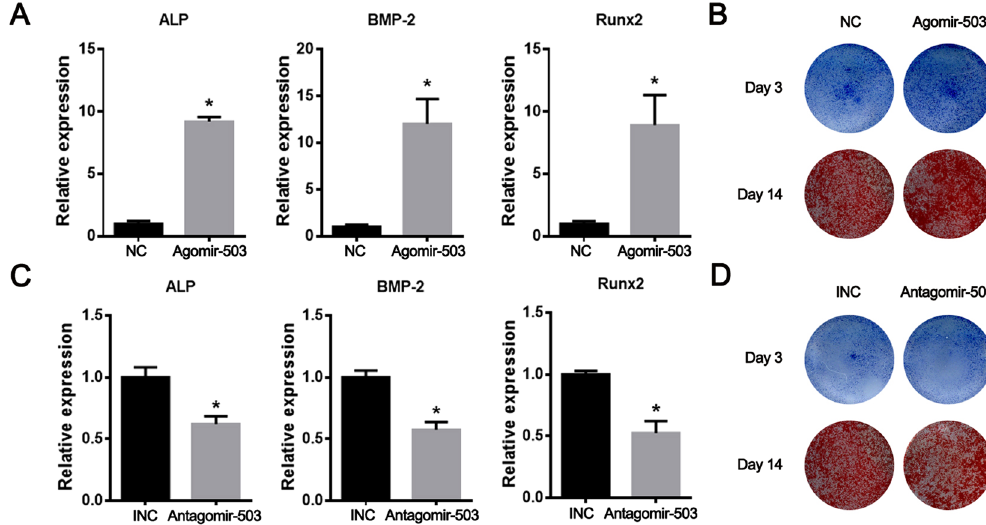
Figure 2. MiR-503 overexpression promotes osteogenic differentiation of rBMSCs. ( A,B ) Agomir-503 and NC were transfected into the rBMSCs by lipofectamine 2000. Three days after transfection, osteogenic differentiation was performed. Expression levels of ALP, BMP2 and Runx2 were detected by q-PCR three days after osteogenic differentiation. ALP and Alizarin red staining were performed 3 days and 14 days after the osteogenic differentiation. The result showed the osteogenic capacity of rBMSCs was significantly promoted by miR-503 overexpression. ( C,D ) As shown in the result, osteogenic capacity of rBMSCs was suppressed after antagomir-503 transfection. (n = 3 each group, * P <